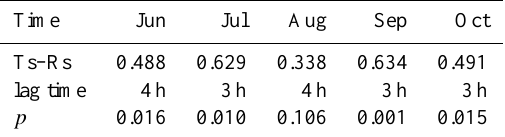
Table 1. Analysis of the mean monthly diel cycles of soil respira- tion (Rs) and soil temperature at 10cm depth (Ts), including Rs– Ts correlation coefficients before synchronized and lag times in the Rs versus Ts diel cycles. The Pearson correlation coefficient and p value were